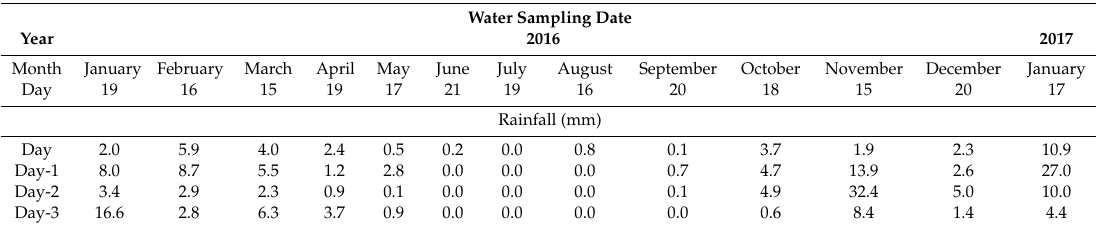
Table 2. Weather conditions (rainfall) in the water sampling day and the three antecedent days (day-1 until day-3). Values larger than 10 mm day-1 are represented in boldface. Source: Valera et al. [15].